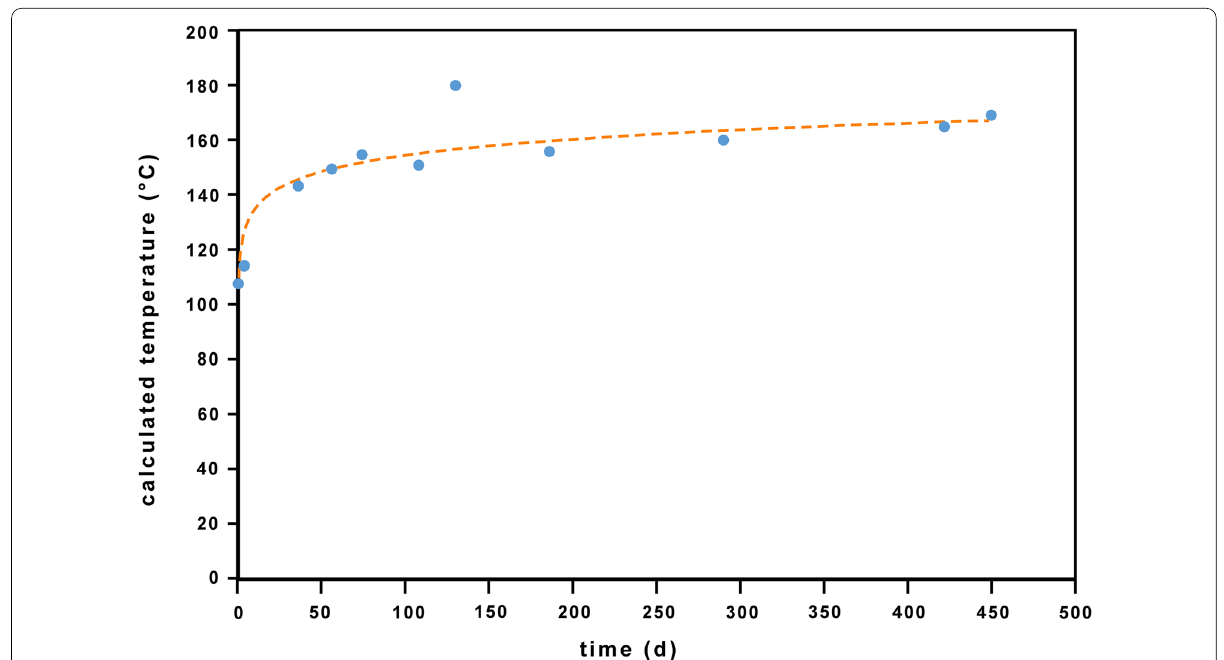
Fig. 10 Temperatures derived from the Mg–K-geothermometer vs. sampling time (days after first sample). First water sample was taken 11th Dec. 2006. Ideal solid-solution of the endmember components in K-feldspar (95 mol%), white mica (95 mol%) and chlorite (50 mol%) (Eq. 8). For complete alteration assemblage see Table